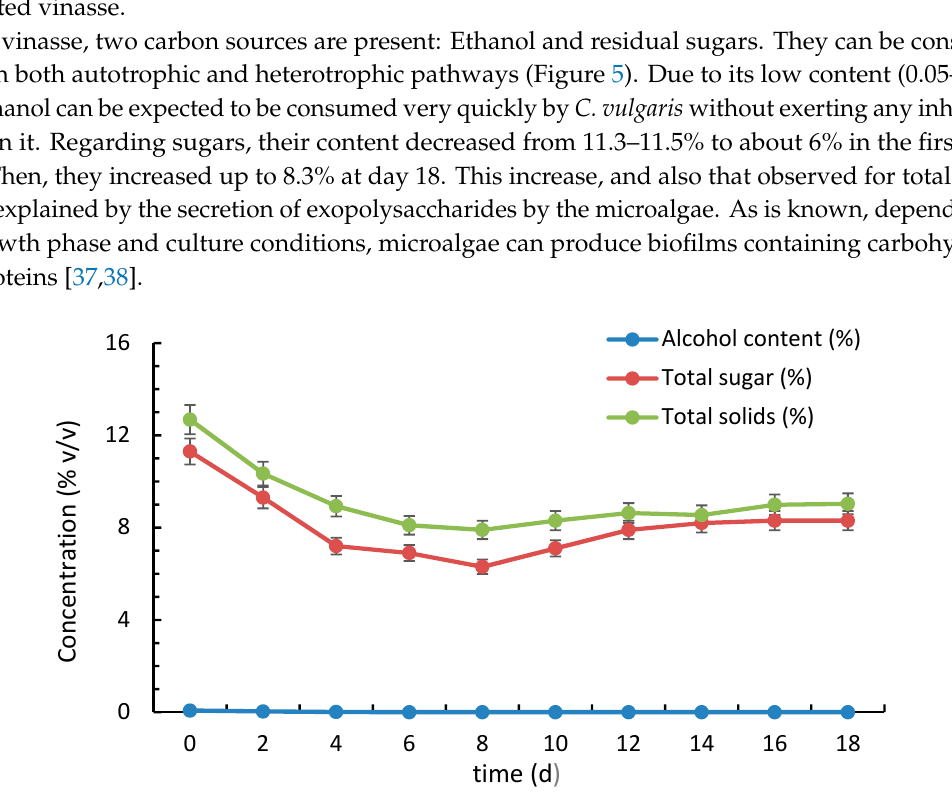
Figure 5. Variation in total solids, total sugars and alcohol content in vinasse in the C2 treatment.